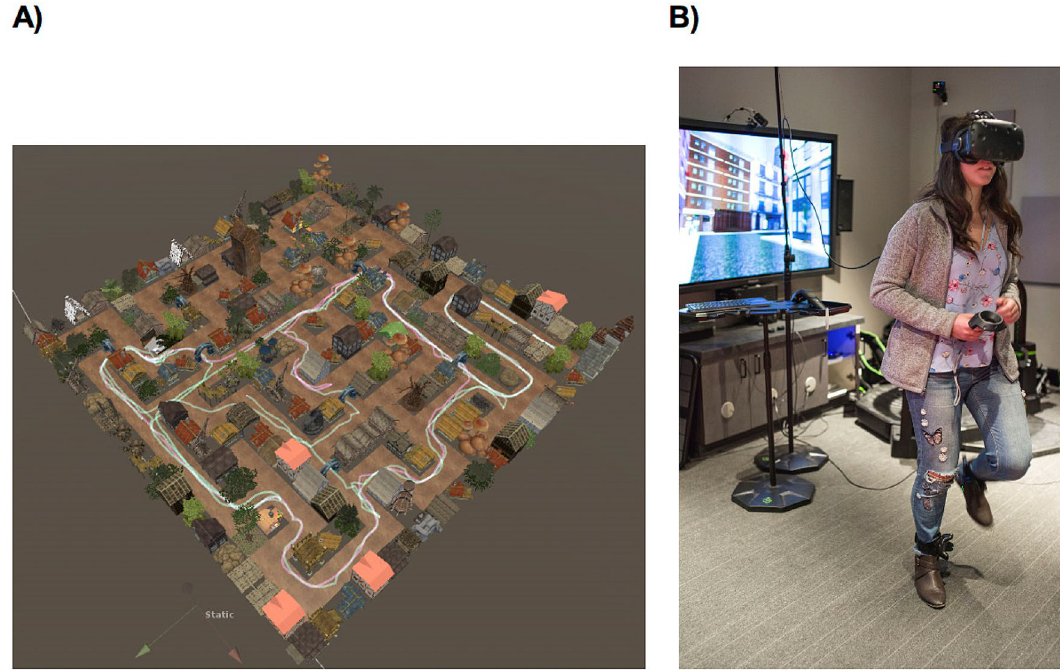
Figure 1. Illustrations of the virtual reality game in Experiment 2 (A) Via a head-mounted virtual reality display, participants had a first-person view of wayfinding trials. The game goal was to learn and efficiently complete errands, as illustrated here with the overhead perspective of the feedback screen from a Village neighborhood. (B) Game movement was effected by a participant’s ambulation, which was co-registered into the game map from ankle-mounted tracking